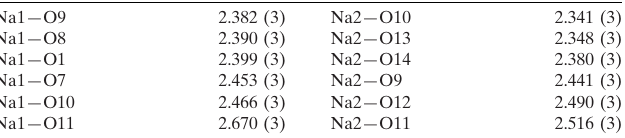
Selected bond lengths (A˚ ).